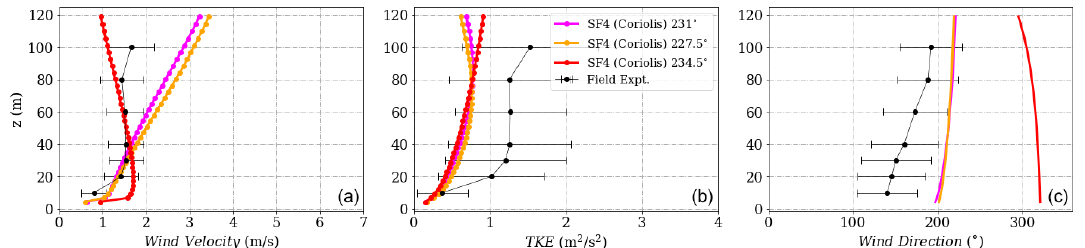
Figure D8. (a) Wind velocity magnitude, (b) wind direction and (c) turbulent kinetic energy at Tower 25 (tse09) for the SF4 (Coriolis) model.